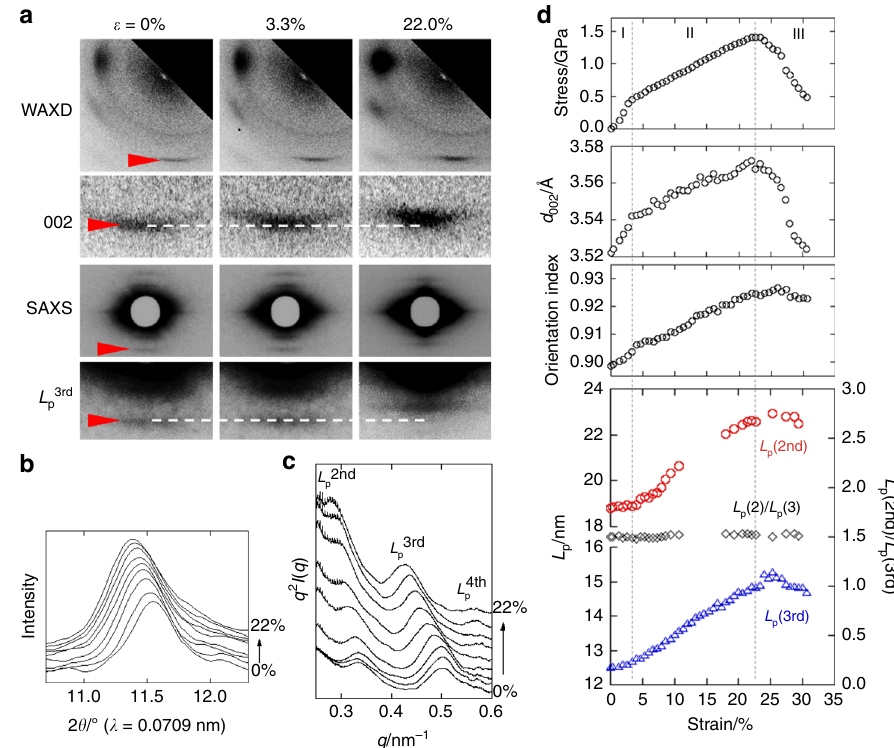
Fig. 4 Time-resolved tracing of structural changes during tensile deformation. a Changes in time-resolved synchrotron WAXD and SAXS patterns during the tensile deformation process. The corresponding stress – strain curve is shown at the top of d . b The selective meridional WAXD 2 θ pro fi les and c the meridional SAXS q 2 I ( q ) vs. q pro fi les, both of which were obtained from the strains at 0, 1.3, 3.3, 6.0, 8.7, 12.0, 14.7, 18.0, and 22.0% in the stress – strain curve shown at the top of d . d Summary of the time-resolved simultaneous measurement. From top to bottom, the changes in the tensile stress, crystal unit cell dimension along the c -axis direction ( d 002 ), crystalline orientation index, and meridional long periods ( L p 2nd and L p 3rd ), estimated from the 2nd and 3rd periodic scatterings, are plotted against the bulk strain. In the bottom plots of the long periods, the ratio of L p 2nd / L p 3rd is also plotted